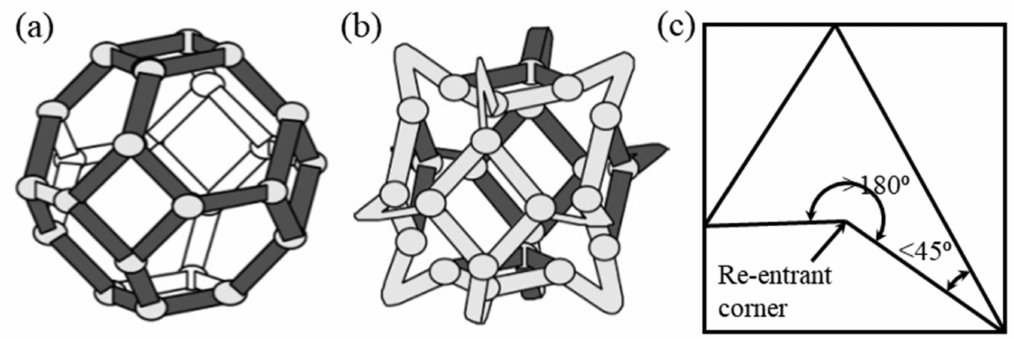
Figure 7. ( a ) Conventional cell, and ( b ) ideal auxetic cell [52], ( c ) re-entrant corner and re-entrant angle in irregular polygon [53].